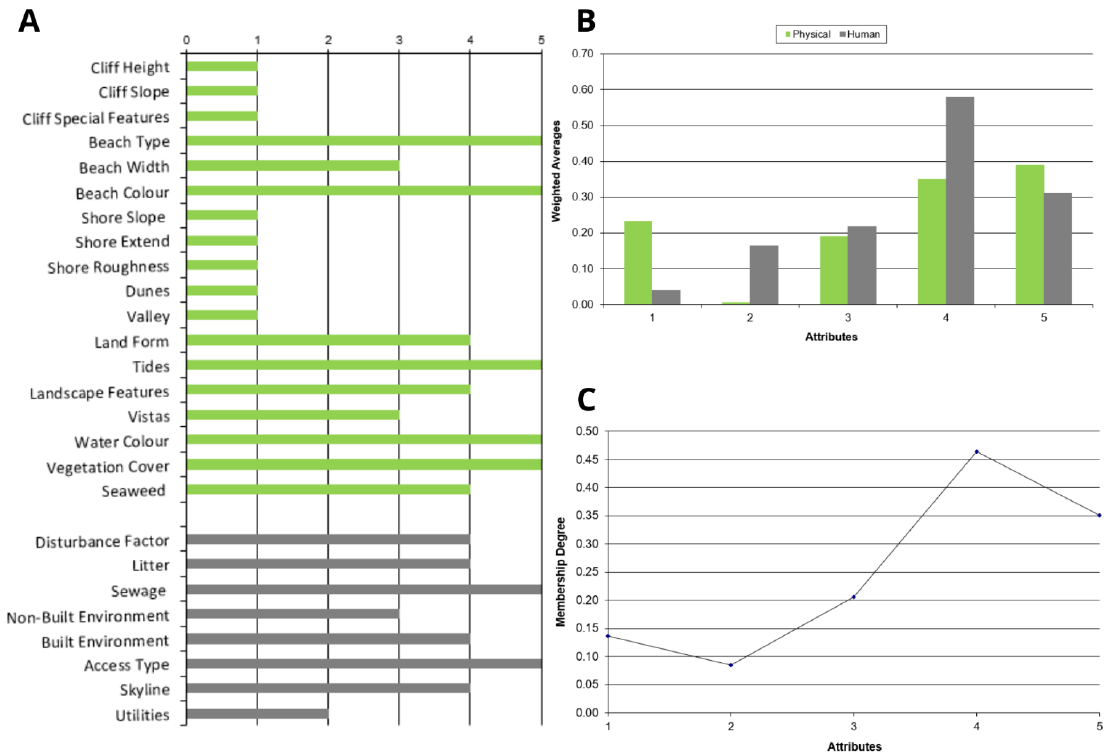
Figure 5. CSES parameters ratings for Formentor, Mallorca (D: 0.77; class II) ( A ), weighted averages vs. attributes ( B ) and membership degree vs. attributes ( C ).